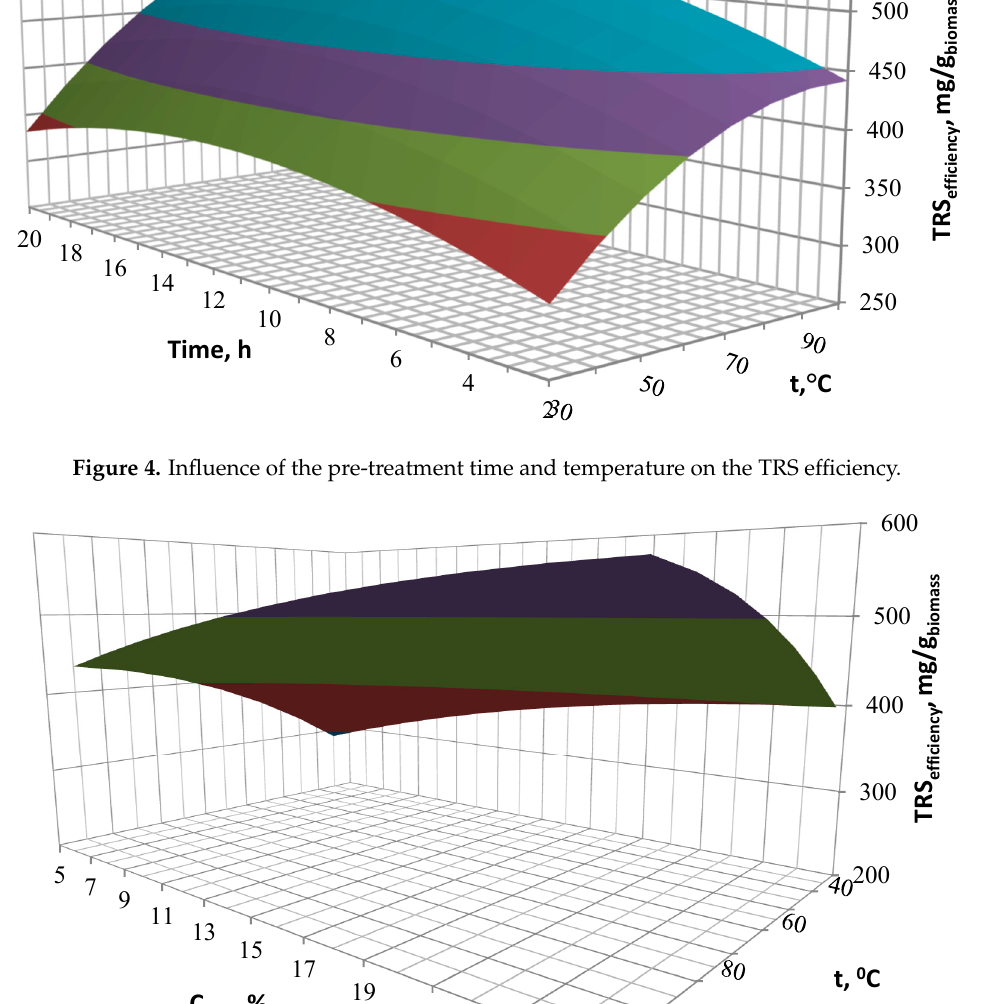
Figure 5. Influence of the pre-treatment temperature and MEA concentration on the TRS efficiency.